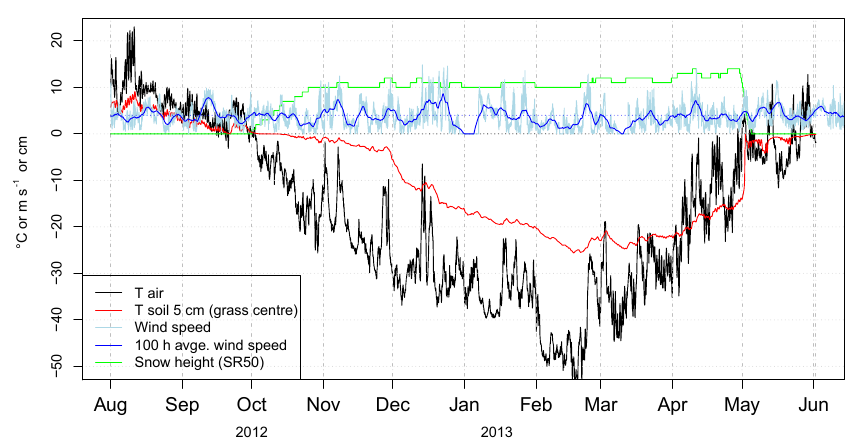
Figure 2. Meteorological, snow, and soil conditions at Samoylov over the 2012–2013 snow